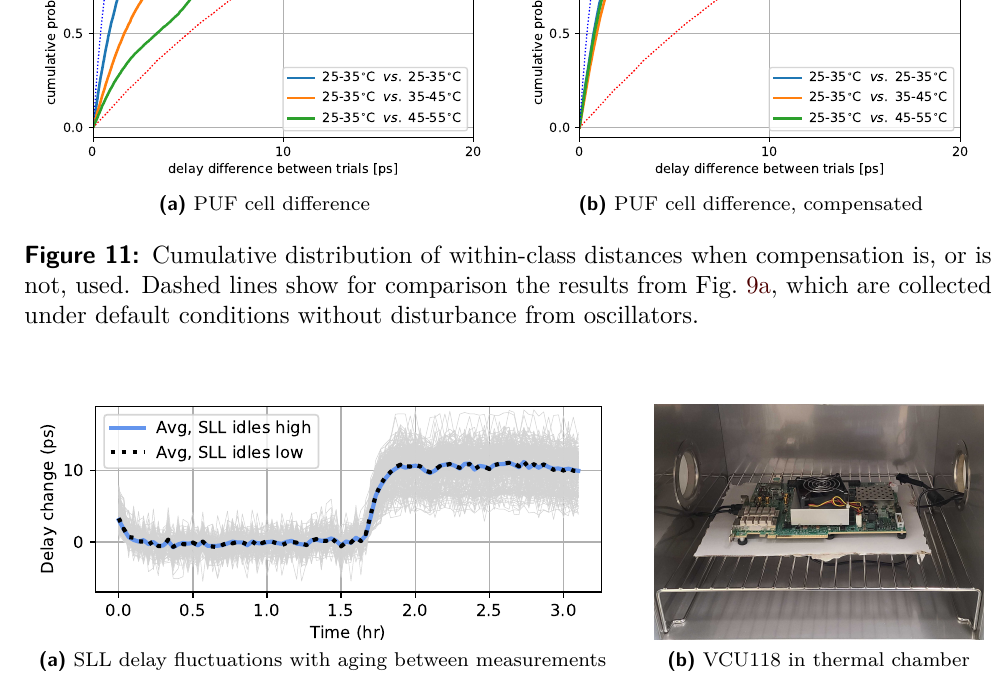
Figure 12: Average delay drift measurements for two groups of SLLs, which are aged using opposite states. The temperature is kept at 25 ◦ C for the first 1.5 hours, and then raised to 50 ◦ C. The delays fluctuate across time and temperature as expected, but there are no differences between the delay changes of the two groups due to their aging